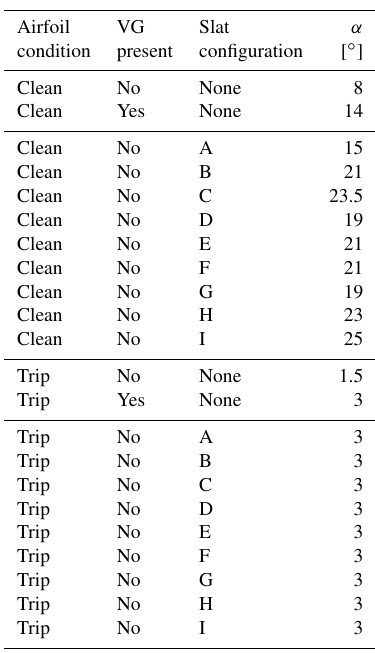
Table A1. Values of angles of attack below which the wake-rake drag is